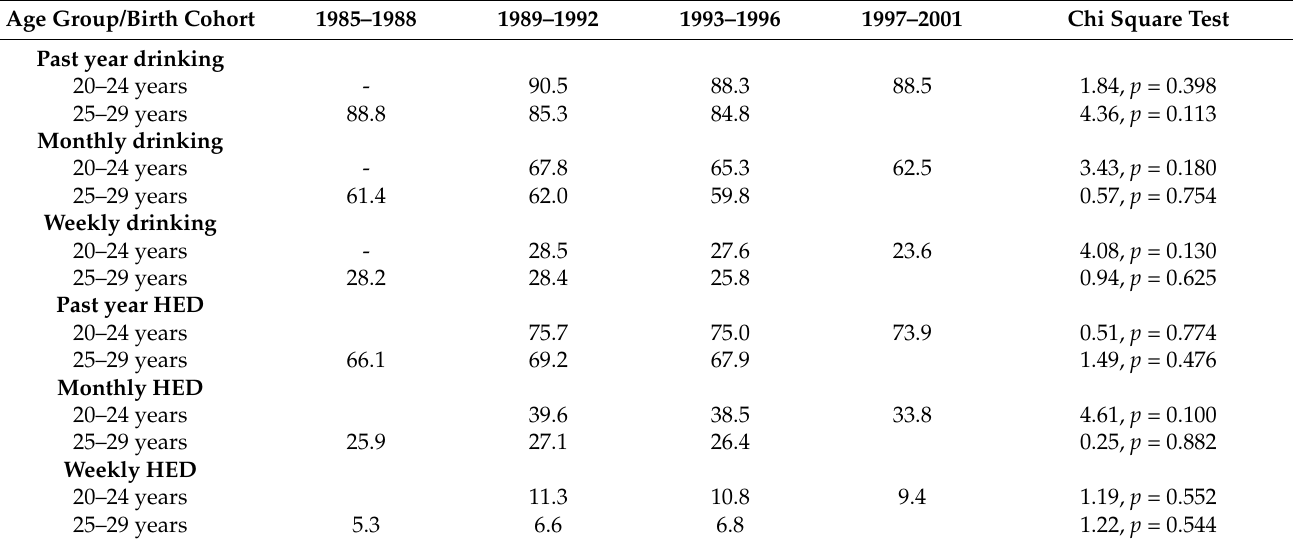
Table 2. Drinking behaviour prevalence by birth cohort and age group. Percent. Unweighted data.